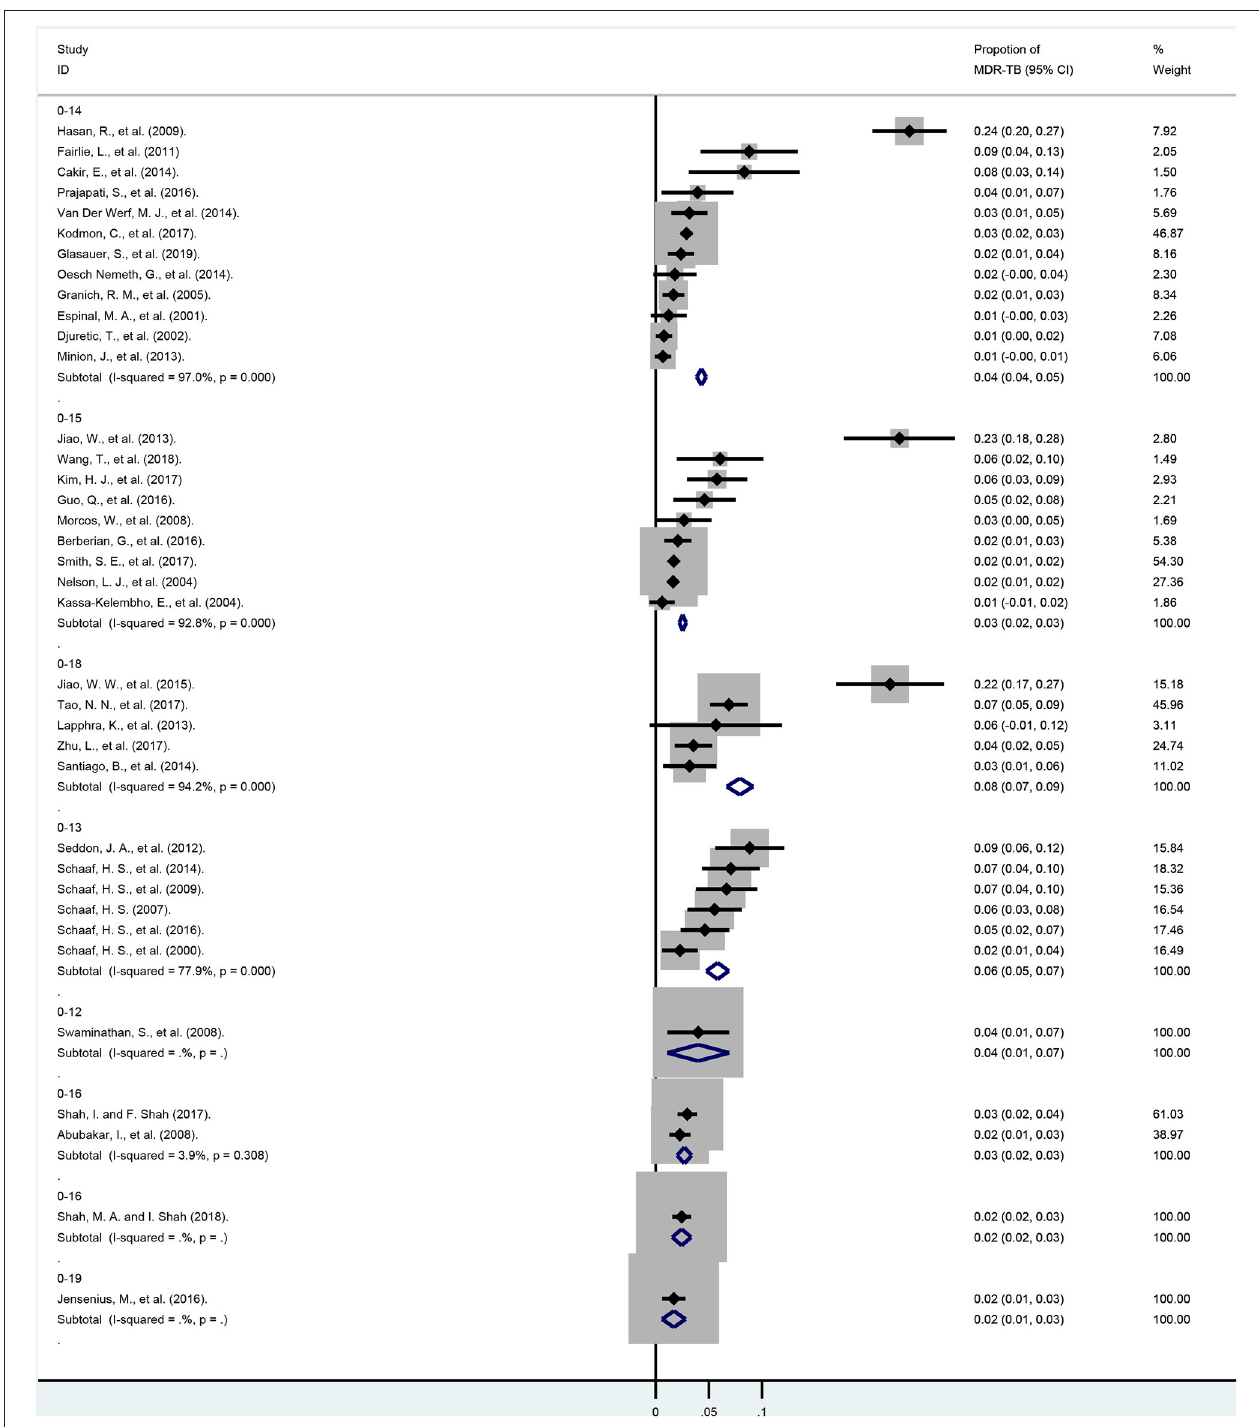
FIGURE 4 | Forest plots for multidrug-resistant tuberculosis ratios from 37 studies in different age subgroups. MDR-TB, multidrug resistant tuberculosis; Horizontal lines represent the 95% CIs around the point estimates for each study and the gray shaded areas are proportional to the weight given to each study.